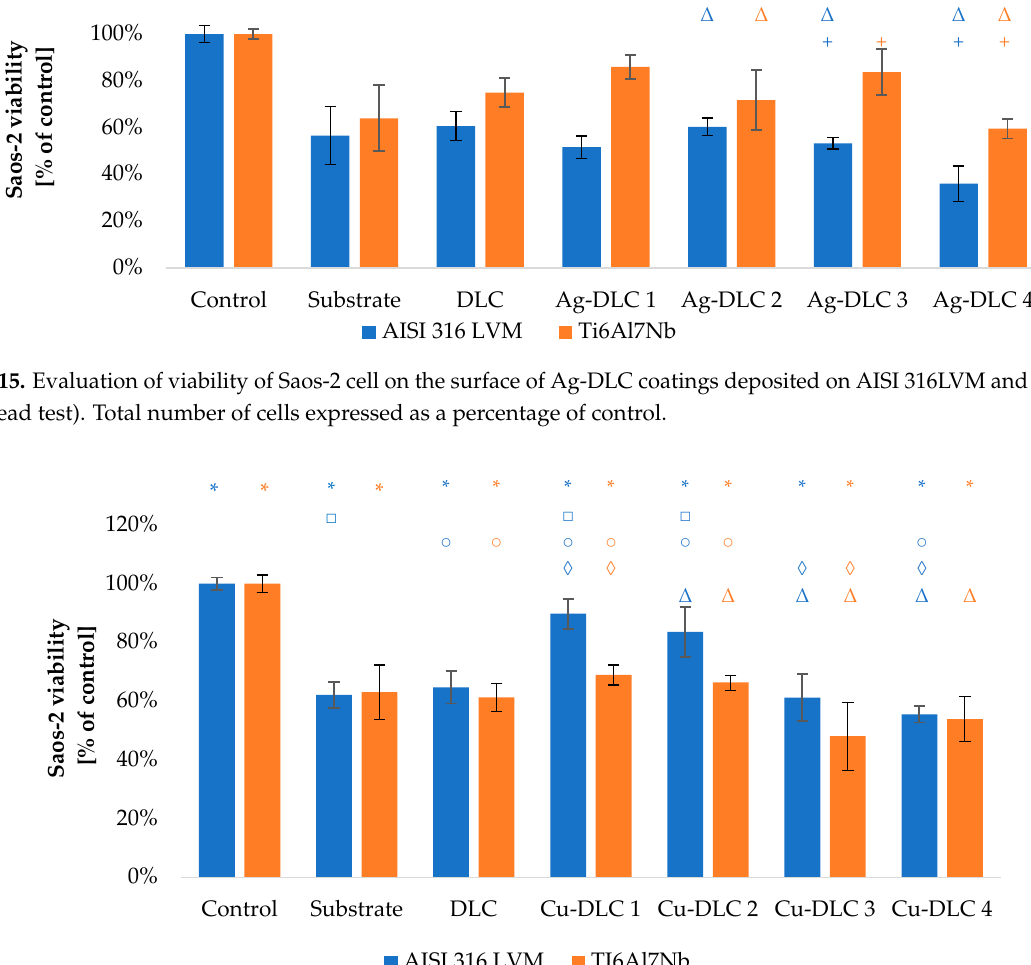
Figure 16. Evaluation of viability of Saos-2 cell on the surface of Cu-DLC coatings deposited on AISI 316LVM and Ti6Al7Nb (live/dead test). Total number of cells expressed as a percentage of control.